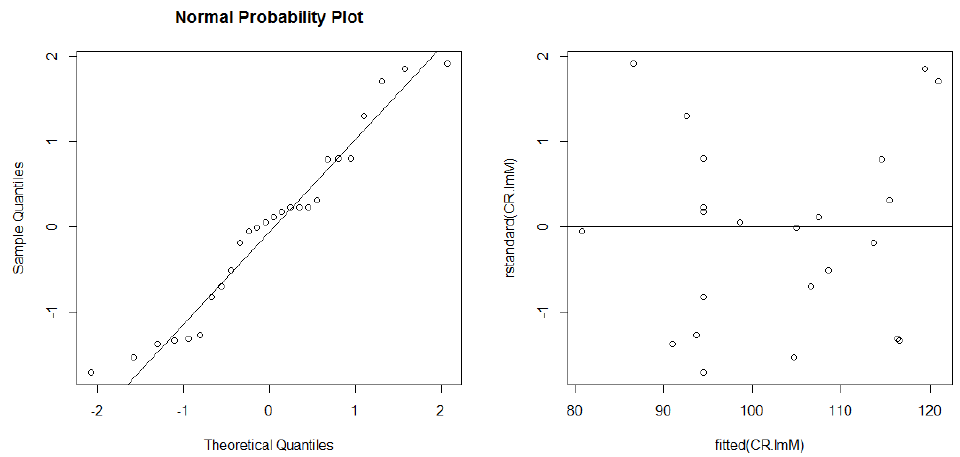
Figure 8. Normal probability plot of residuals, and plot of residuals vs. fitted values, for melt thickness data.